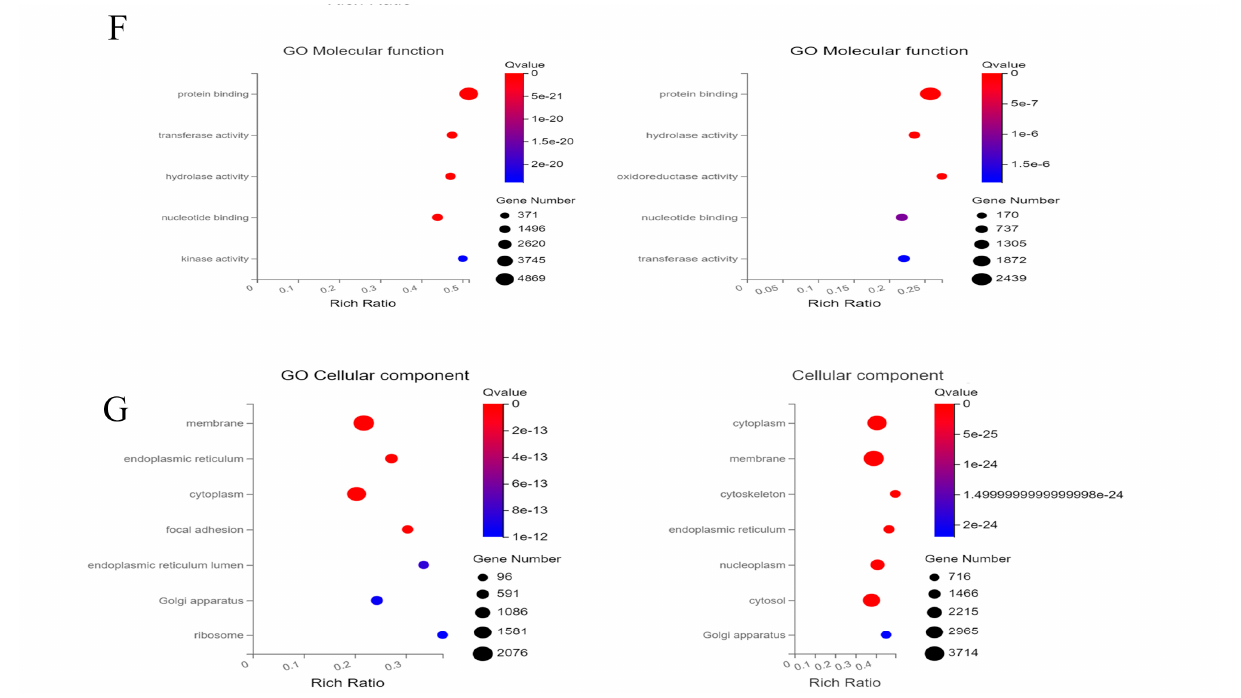
Figure 2. Visualization of gene ontology (GO) enrichment for differential expression genes in cryopre- served ovarian cells. ( A ) Gene ontology classification into functions of biological process (BP), cellular component (CC), and molecular function (MF) in cells of Group 1 (one-time cryopreservation) and Group 2 (two-time cryopreservation). ( B – D ) Top terms of cells from Group 1 (one-time cryopreser- vation) and Group 2 (two-time cryopreservation). ( E – G ) Top terms of cells from Group 3